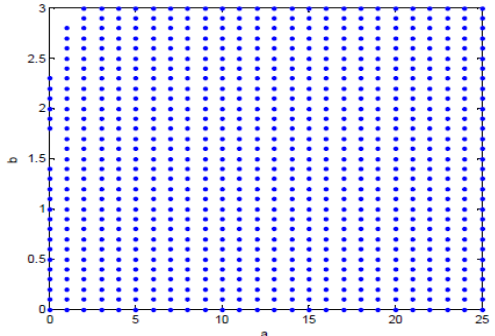
Figure 6. Stability regions for m = 50 and δ = 0.5.